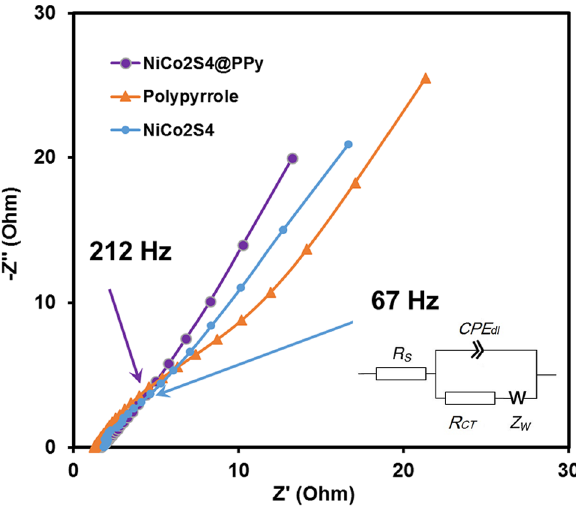
Figure 7. EIS results for the PPy, NiCo 2 S 4 , and NiCo 2 S 4 @PPy electrodes: knee point frequencies for NiCo 2 S 4 and NiCo 2 S 4 @PPy electrodes are emphasized the corresponding arrows. The inset depicts a modified Randles electrical circuit used to fit the EIS